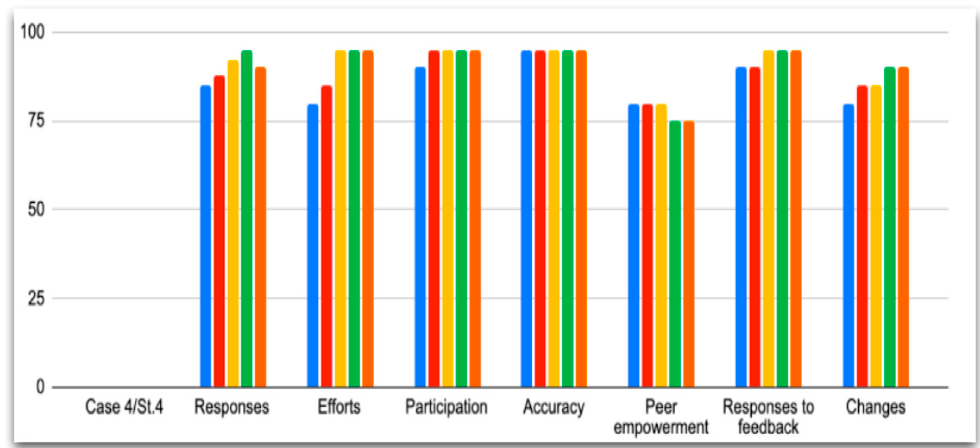
Figure 4. Vocabulary and spelling progress during alternative assessment online/Case 4.